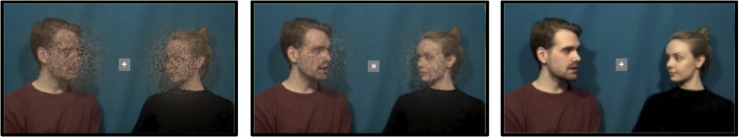
Examples of the visual manipulations. From left to right: Poor, medium and good visual quality. The fixation cross was present during each dialogue and the participants were asked to focus on the cross. Written informed consent was obtained from the actors to publish identifiable image information.